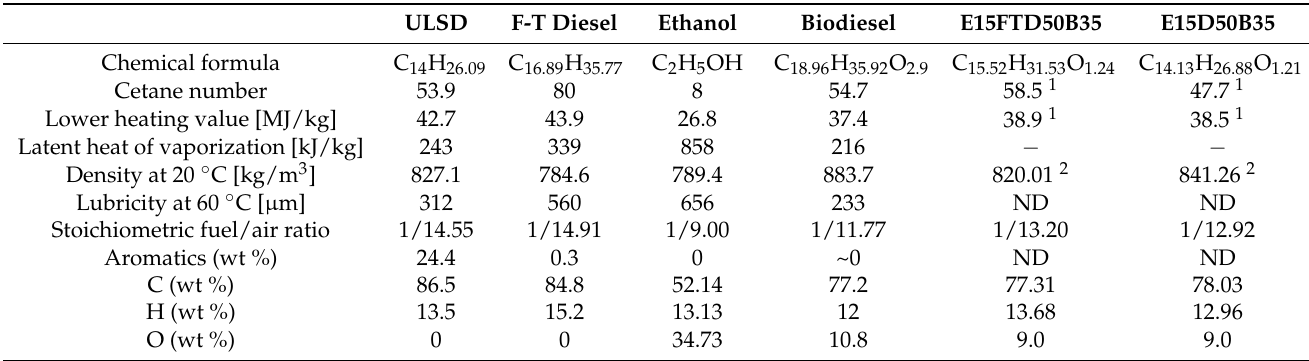
Table 2. Specification of tested fuels.